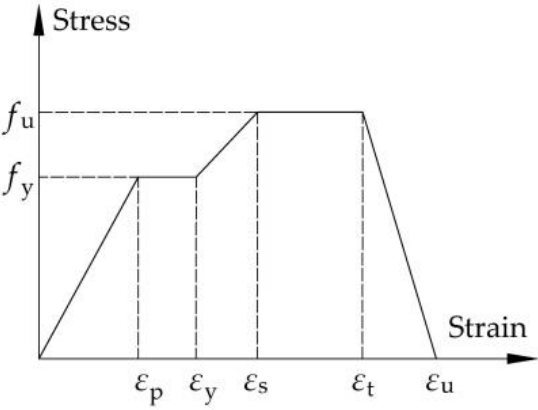
Figure 24. Stress – strain curves of steel members. Figure 24. Stress–strain curves of steel members.